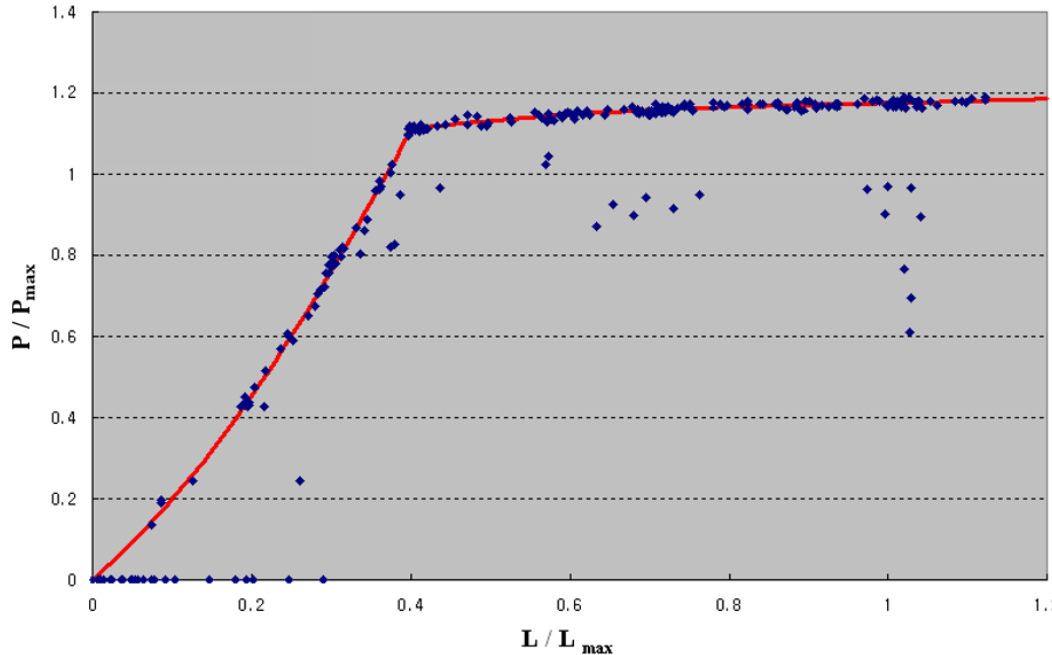
Figure 17. Relationship between electricity production and fuel consumption for a DHN.